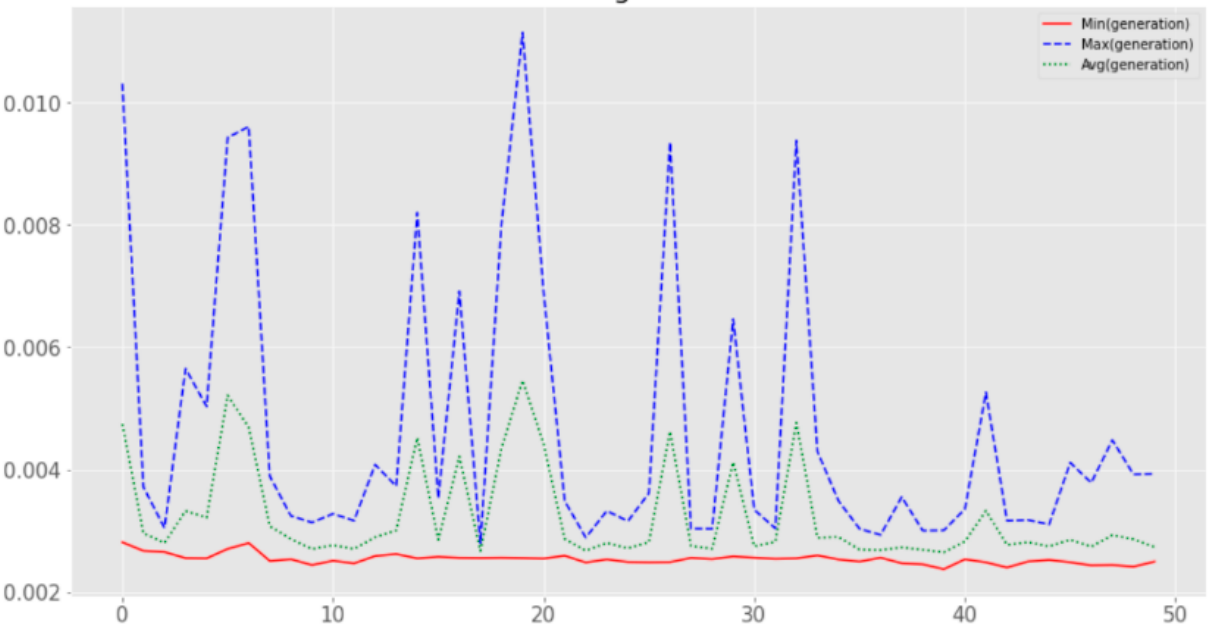
Figure 5. Minimum, maximum and average values of the fitness function for each generation.